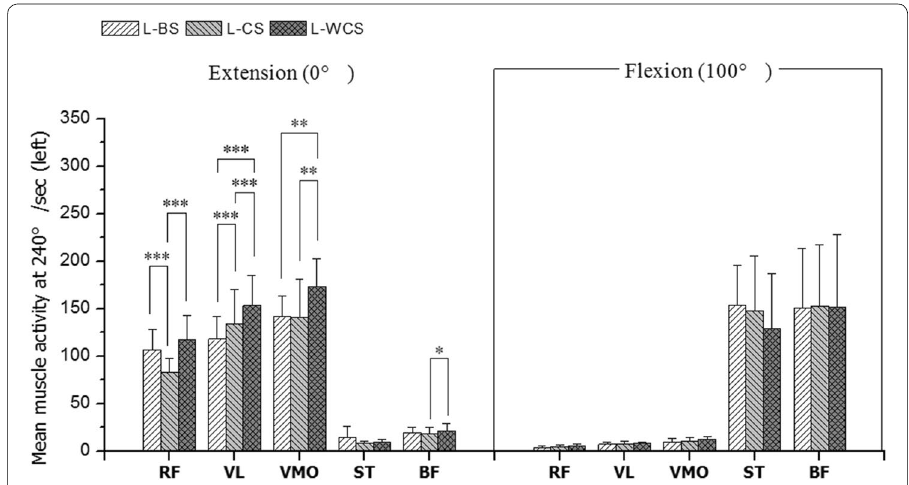
Fig. 7 Mean muscle activities of the left legs at the angular velocity of 240°/s: left (during knee extension); right (during knee flexion)